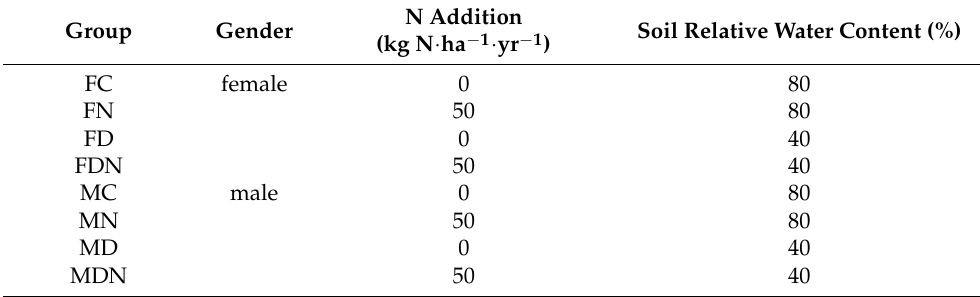
Table 1. The treatments of simulated N deposition and drought in each group.